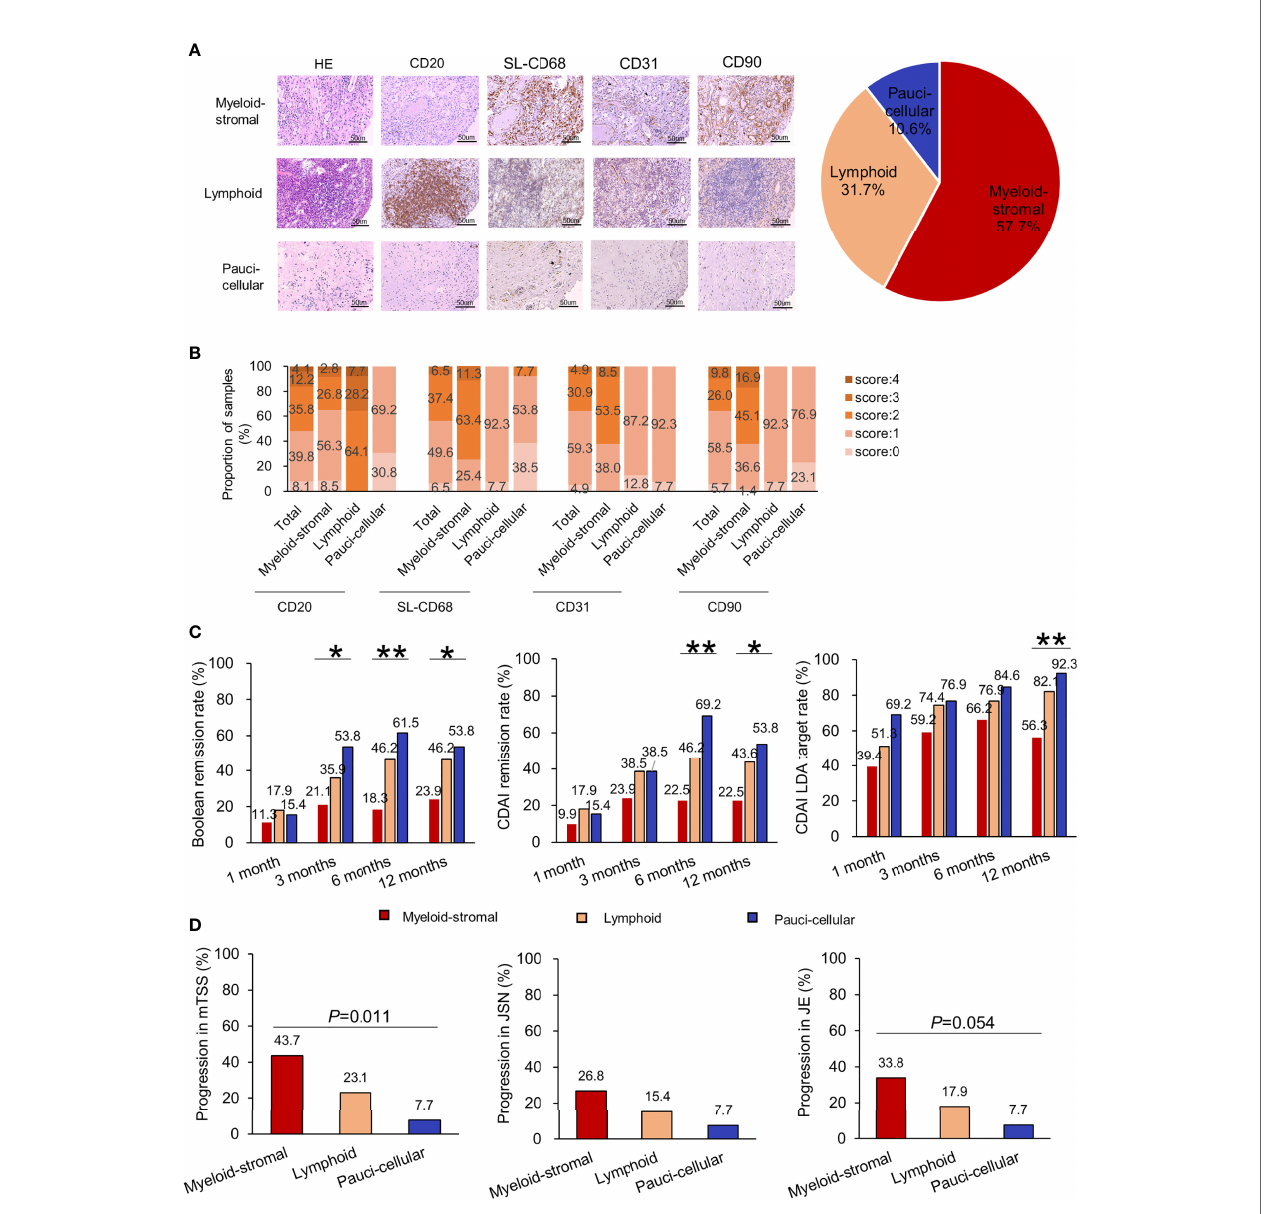
FIGURE 3 | Relationship of synovial pathotypes in the new synovial pathotype classi fi cation and clinical characteristics in RA patients. (A) Representative H&E staining, immunohistochemistry, and distribution of synovial pathotypes. (B) Distribution of each synovial cellular score. (C) Comparisons of therapeutic responses (rates of ACR/EULAR Boolean remission, CDAI remission, CDAI LDA) among different synovial pathotypes at 1, 3, 6, and 12 months. (D) Comparisons of radiographic progression in mTSS, JSN subscore, and JE subscore at 1 year among different synovial pathotypes. Progression in JSN or JE, de fi ned as a minimum increase of 0 unit in the JSN or JE subscore from baseline to 1 year. * p < 0.05; ** p < 0.01 (Chi-square test or Fisher ’ s exact